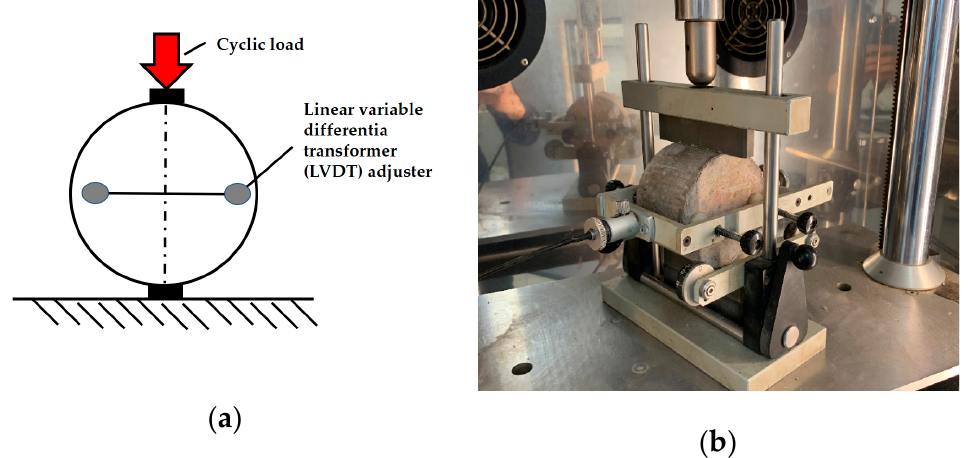
Figure 3. An example of a force applied to the specimen and the loading scheme: ( a ) testing scheme (source: P. Buczy ń ski); and ( b ) set-up for fracture toughness test (laboratory at the Kielce University of Technology, Faculty of Civil Engineering and Architecture) (source: M. Krasowski).